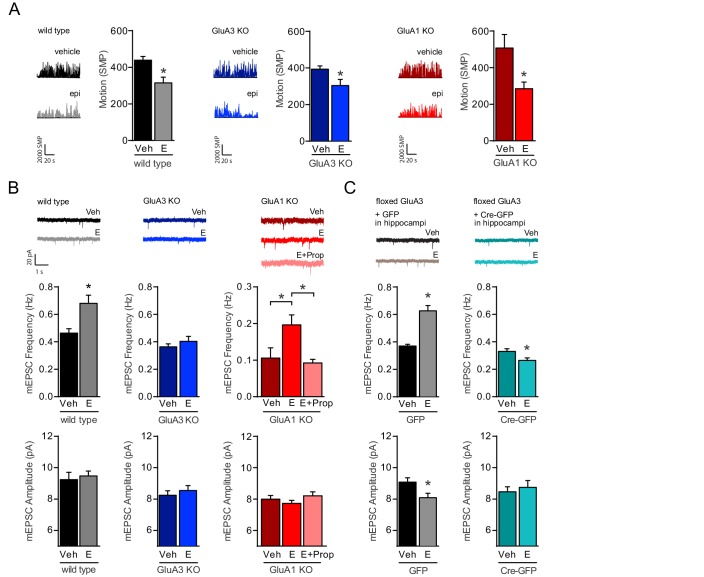
NE release triggers the activation of GluA2/3-plasticity.(A) Example traces and average motion as a change in significant motion pixels (SMPs) (Kopec et al., 2007) of WT injected with saline (n=15) or E (n=15), GluA3-KO injected with saline (n=17) or E (n=16), and GluA1-KO injected with saline (n=10) or E (n=11). Epinephrine (E) injection decreases the motion of mice (t-test, WT: p=0.003; GluA3-KO: p=0.02; GluA1-KO: p=0.01). (B) Example traces, mEPSC frequencies and mEPSC amplitudes of CA1 hippocampal neurons from WT mice injected with saline (n=13) or E (n=15) (t-test, Freq: p=0.0003; Ampl: p=0.6); GluA3-KO mice injected with saline (n=16) or E (n=13) (t-test, Freq: p=0.4; Ampl: p=0.5); or GluA1-KO mice injected with saline (n=12), E (n=20) or propranolol 20 min prior to E (n=16) (Freq: ANOVA, veh vs E: p=0.008; E vs E + Prop: p=0.04; veh vs E + Prop: p>0.9) (Ampl: ANOVA, p=0.2). (C) AAV virus expressing GFP or GFP-Cre were stereotactically targeted at the CA1 of flGluA3 mice. Example traces, mEPSC frequencies and mEPSC amplitudes recorded from GFP-positive CA1 neurons after injection with epinephrine (GFP: n=11; GFP-Cre: n=9) or saline (GFP: n=11; GFP-Cre: n=11). In GFP-infected neurons E-injection caused an increased mEPSC frequency (t-test, p<0.0001) and decreased amplitude (t-test, p=0.02). In GFP-Cre infected neurons E-injection caused a decrease in mEPSC frequency (t-test, p=0.02) and no change in amplitude (t-test, p=0.6). Error bars indicate SEM, * indicates p<0.05.